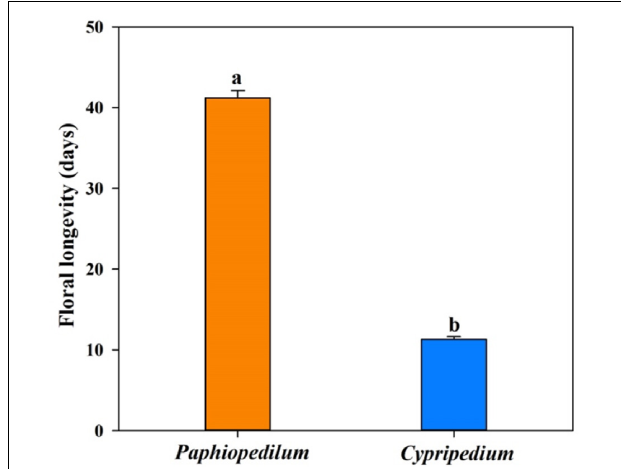
FIGURE 1 | The floral longevity in Paphiopedilum and Cypripedium genera. SEs are presented with bars, and different letters signify statistically significant